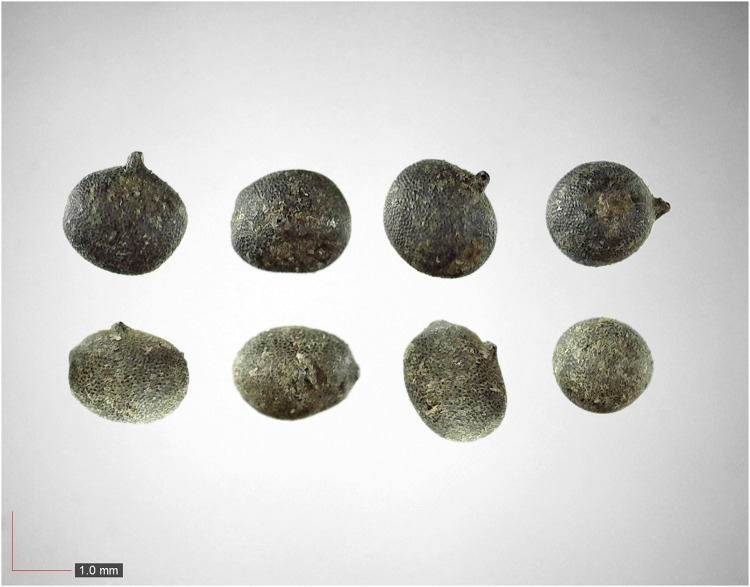
Unidentified 10.Table 2.